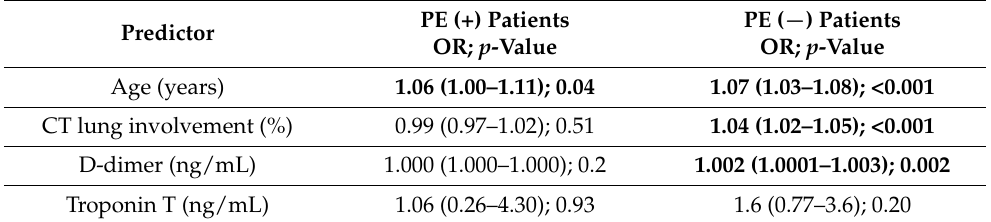
Table 3. Independent predictors of mortality in PE (+) COVID-19 (+) patients and PE ( − ) COVID-19 (+) patients. Data are presented as odds ratio followed by 95% confidence interval and p -value.